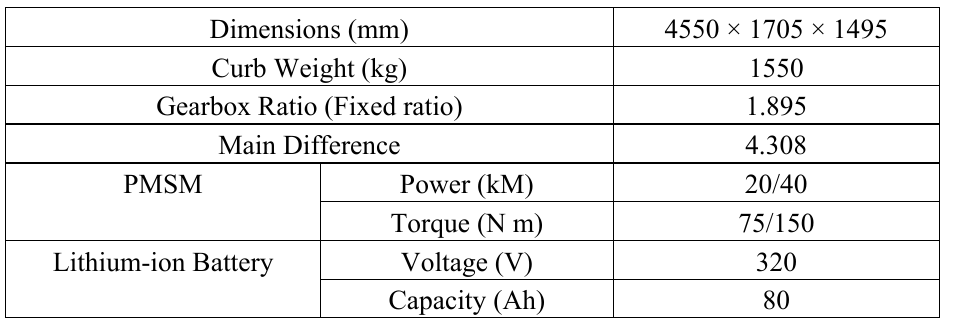
Table 1. Vehicle